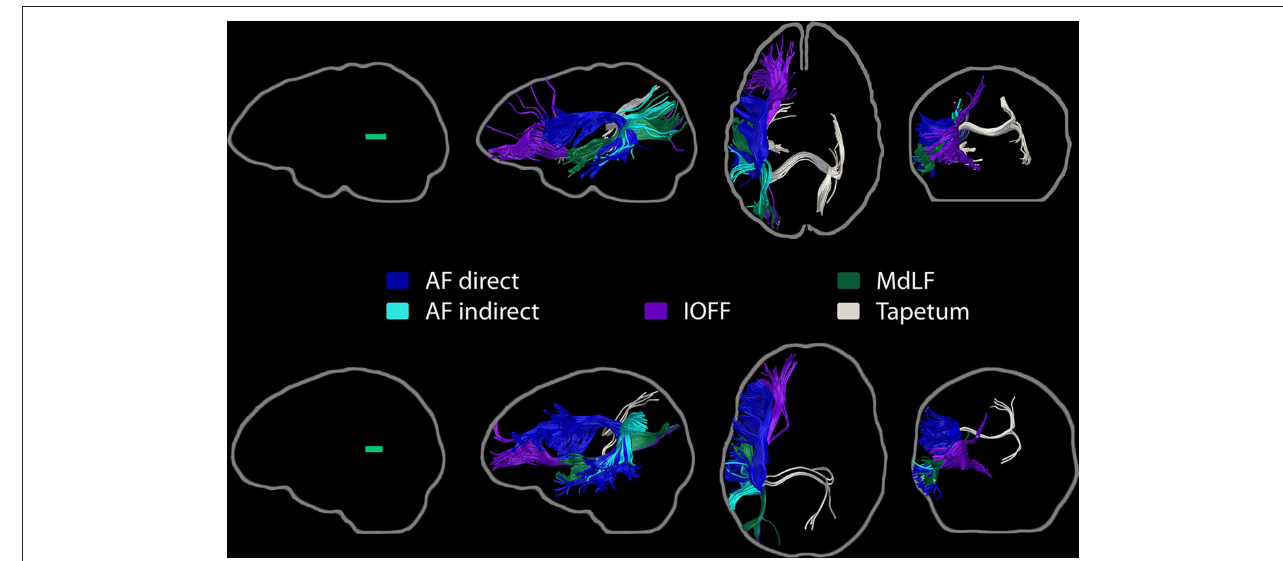
indirect segments of the arcuate fasciculus, the inferior occipito-frontal fasciculus, the middle longitudinal fasciculus, and the tapetum are shown for the two subjects chosen as exemplars.